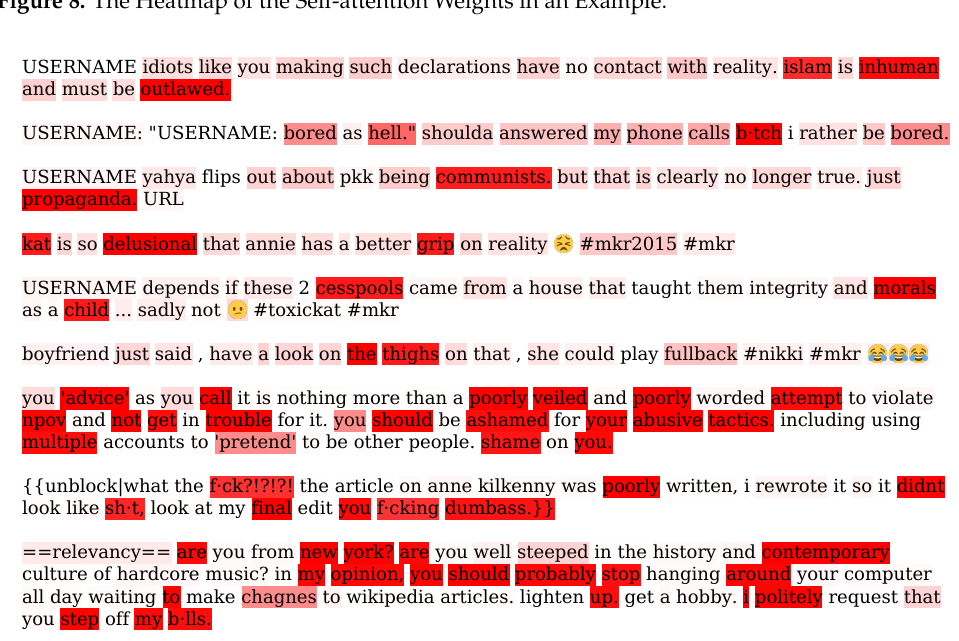
Figure 8. The Heatmap of the Self-attention Weights in an Example.